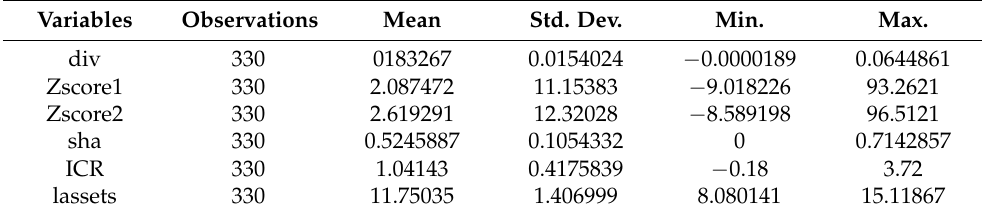
Table 2. Descriptive